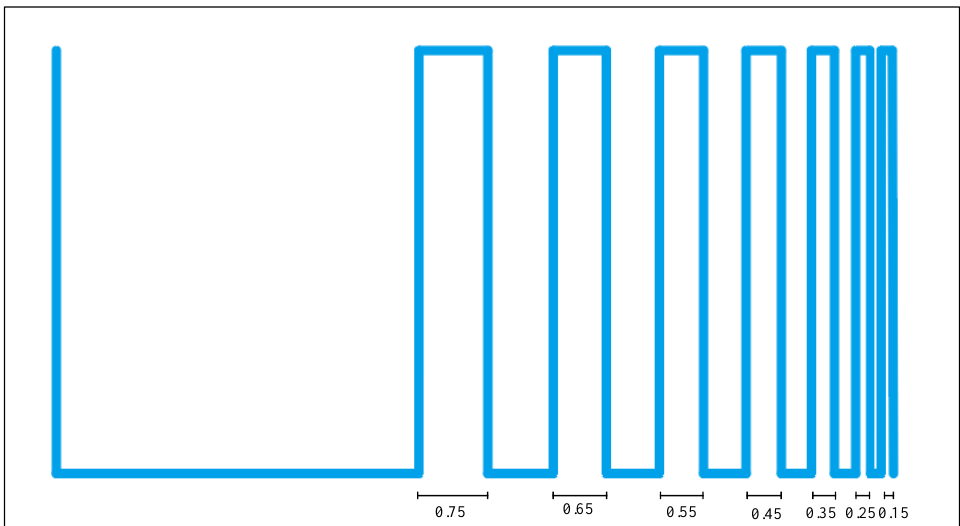
Figure 10. Print of the gradient line trajectory.